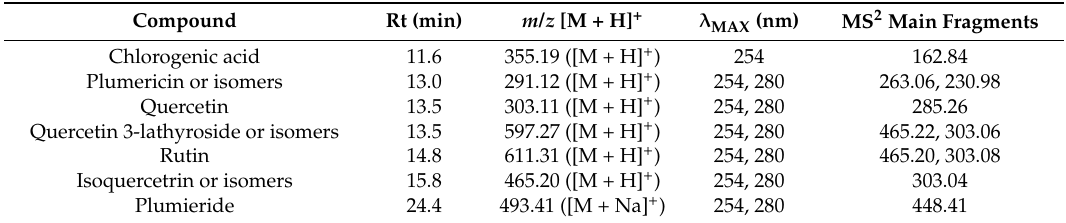
Table 3. Identification of compounds in the hydroalcoholic extract from leaves of Himatanthus. drasticus by HPLC-ESI-MS analysis.